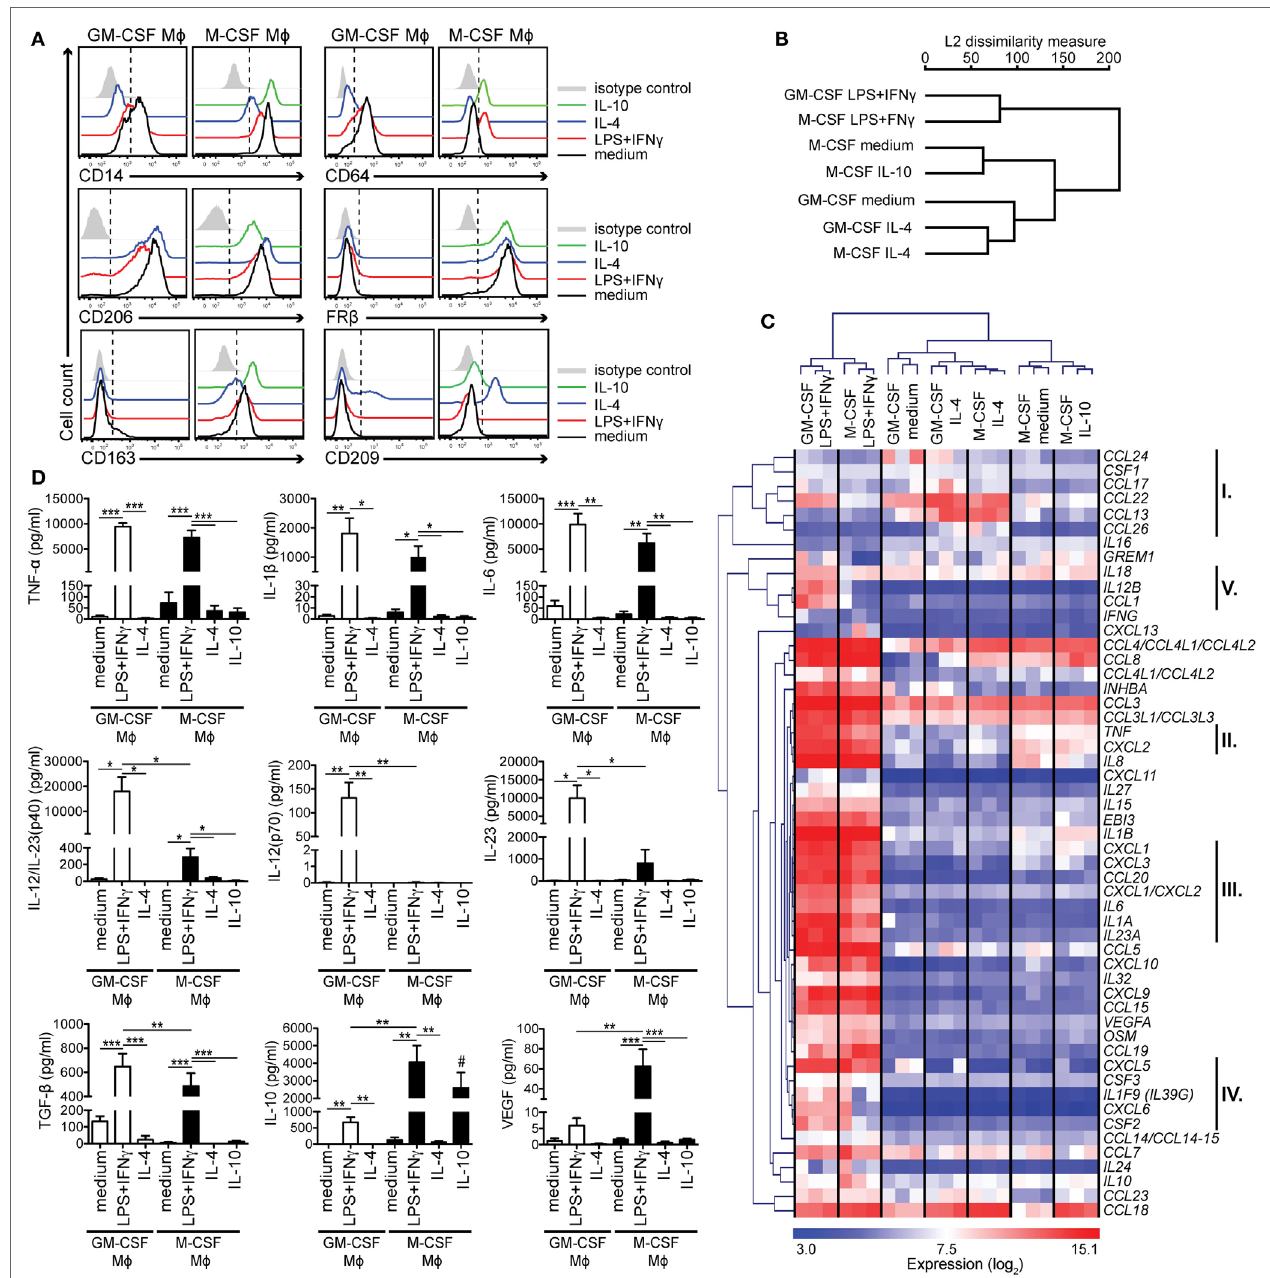
FigUre 1 | Activated human GM-CSF- and M-CSF-differentiated macrophage (M ϕ ) subtypes are distinguishable by their surface marker, cytokine, and chemokine profiles. Human M ϕ s were differentiated for 7 days with either GM-CSF or M-CSF and then activated for 2 days with the indicated stimuli. (a) Surface expression of M ϕ markers was measured by flow cytometry. Mock-activated cells are shown in black, cells activated with—LPS + IFN γ in red, with IL-4 in blue and with IL-10 in green. Control staining of mock-activated cells using the isotype control monoclonal antibodies is shown in gray (isotype control staining of activated cells was similar and is not depicted here). One representative of 10–12 experiments is shown. (B) Genome-wide analysis of M ϕ polarization was assessed by transcriptome profiling of M ϕ subtypes from (a) . Hierarchical clustering of M ϕ subtypes based on 22,067 gene probe sets ( ≈ 44.7%) that showed a significantly different expression (adj. p value < 0.05) in at least one comparison. Data are combined from three independent experiments. (c) Heat map of transcripts of cytokine and chemokine genes based on the differentially expressed gene probe sets (115 gene probe sets; adj. p value < 0.05) with log 2 expression > 7 in at least one sample. Important gene clusters discussed (I–V) are highlighted on the right. M ϕ s have been generated from three donors and are visualized separately. (D) Active TGF- β from cell-free culture supernatants was determined using the SERPINE1 (PAI-1) promoter-driven luciferase reporter assay, while the other cytokines were measured by the Luminex analysis. The mean cytokine concentration ± SEM from 5 to 6 donors is shown. * p < 0.05, ** p < 0.01, *** p < 0.001. Statistical significance was determined by one-way ANOVA with Tukey’s posttest. The hash key (#) indicates that the IL-10 levels in the IL-10-stimulated M ϕ subtype represent a mixture of released and residual IL-10 from the activation step and, therefore, were not